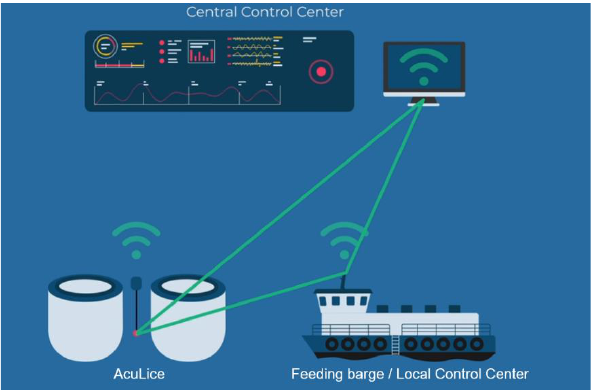
Figure 1. Set up of the AcuLice system. The AcuLice system consists of a central control room with monitoring, an electronic processor located at the facility, and a component in the sea (that sends out low-frequency sound waves). The whole system is connected to the